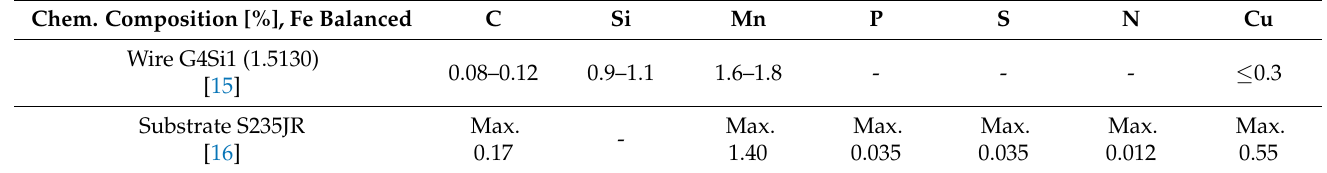
Table 1. Chemical composition of welding wire SG3/G4Si1 (1.5130) and substrate S235JR, Fe balanced. Chem. Composition [%], Fe Balanced C Si Mn P S N Cu Wire G4Si1 (1.5130)